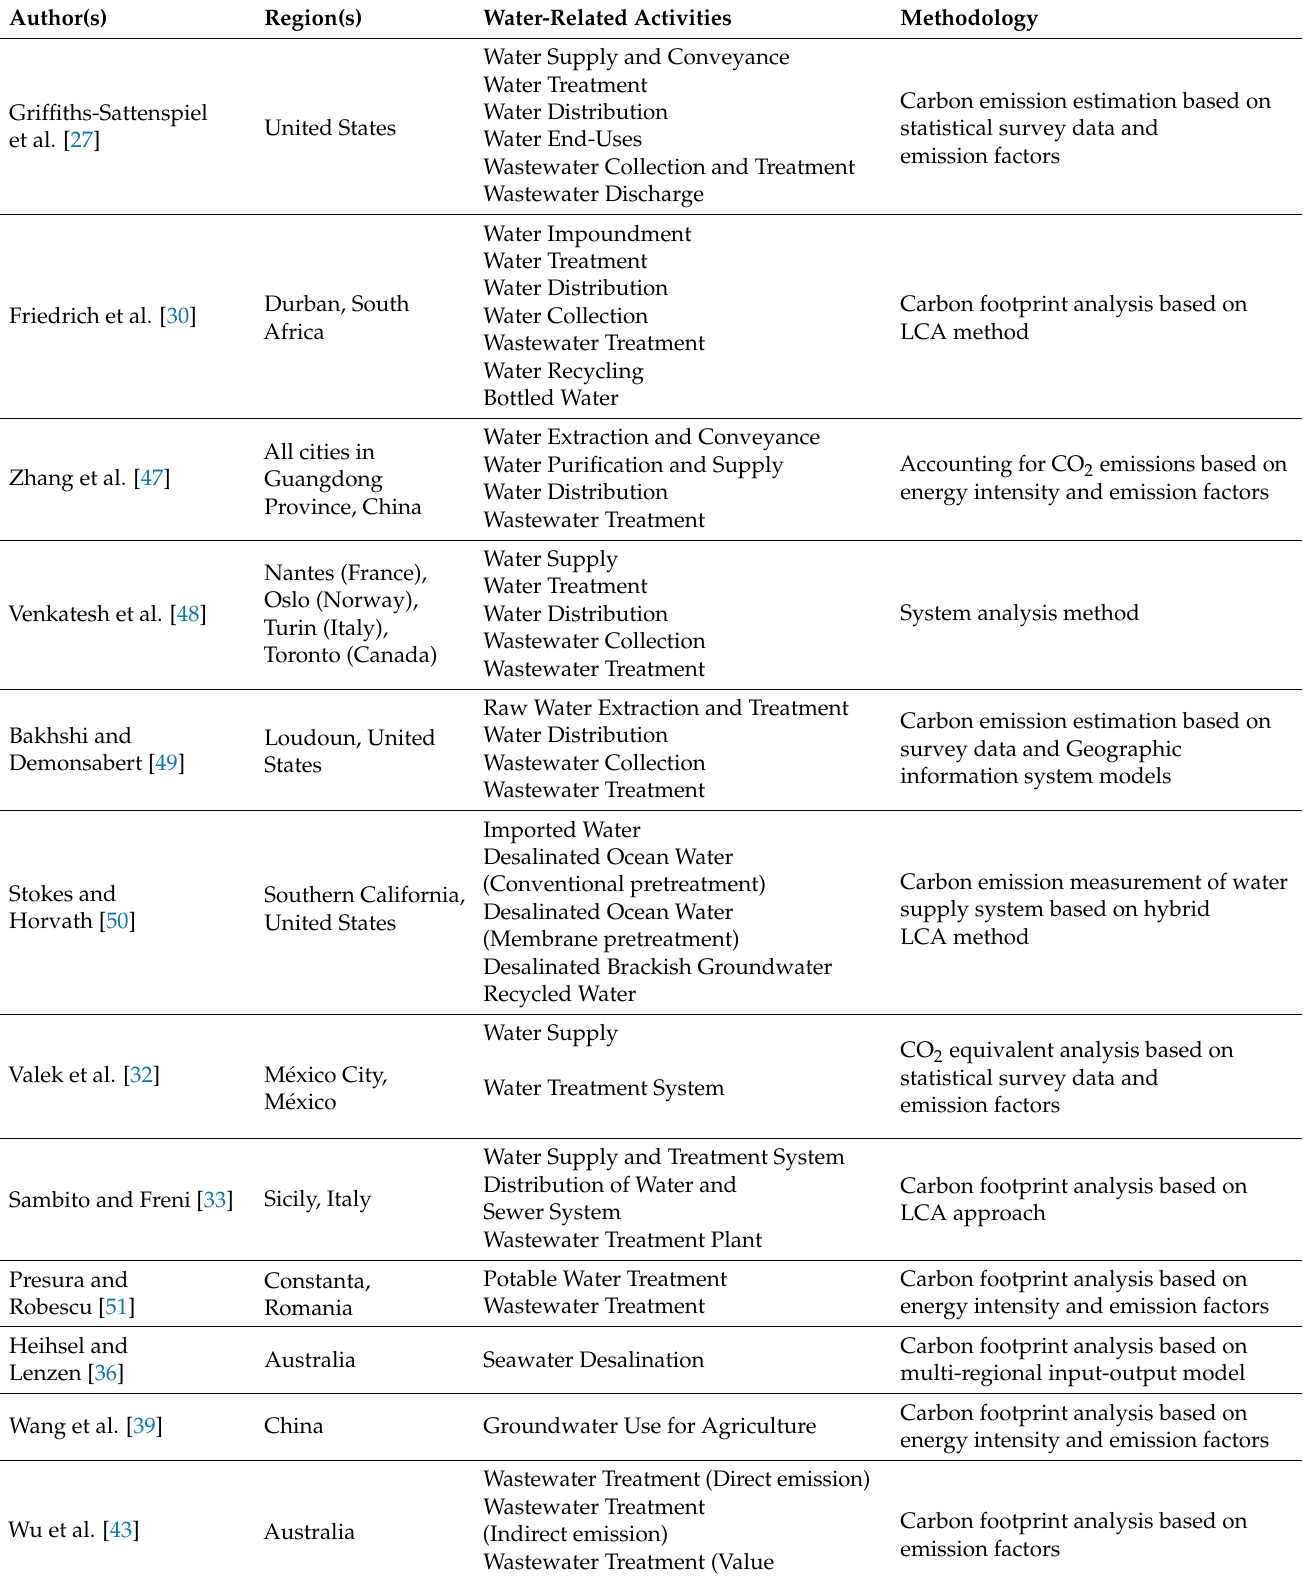
Table 1. Selected representative literature of carbon emission effect studies in the field of water